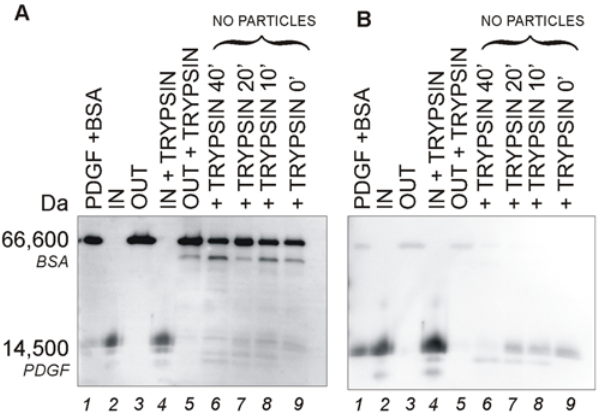
Figure 9. Immunoblot analysis showing that core-shell parti- cles protect captured PDGF from tryptic degradation. (A) Sypro ruby total protein staining and (B) Immunoblot analysis with anti-PDGF antibody of the same PVDF membrane are presented. Lane 1) control PDGF + BSA solution; 2) content of particles incubated with PDGF + BSA (IN); 3) supernatant of particles incubated with PDGF + BSA (OUT); 4) content of particles incubated with BSA + PDGF + trypsin (IN + TRYPSIN); 5) supernatant of particles incubated with BSA + PDGF + trypsin (OUT +- TRYPSIN); 6) BSA + PDGF + trypsin without particles incubated for 40 minutes ( + TRYPSIN 40 9 ); 7)) BSA + PDGF + trypsin without particles incubated for 20 minutes ( + TRYPSIN 20 9 ); 8)) BSA + PDGF + trypsin without particles incubated for 10 minutes ( + TRYPSIN 10 9 ); 9))